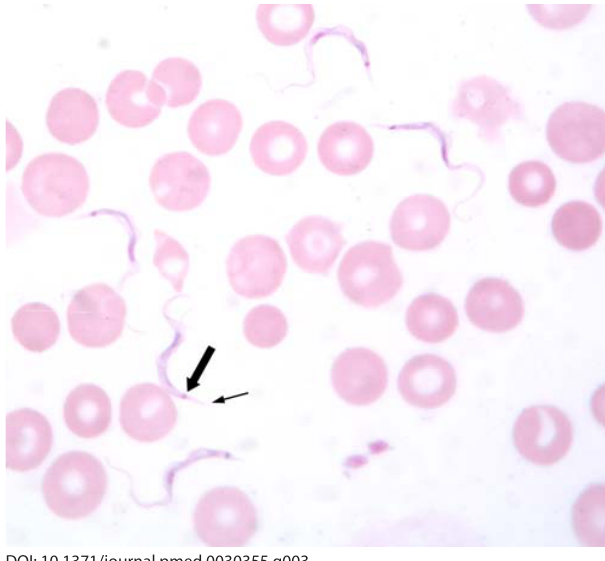
Figure 3. Thin Blood Film of the Patient Showing Five Trypanosomes and Several Red Blood Cells Arrows indicate the pointed posterior segment (small arrow) and the large kinetoplast (large arrow) that distinguish these from T. b. gambiense